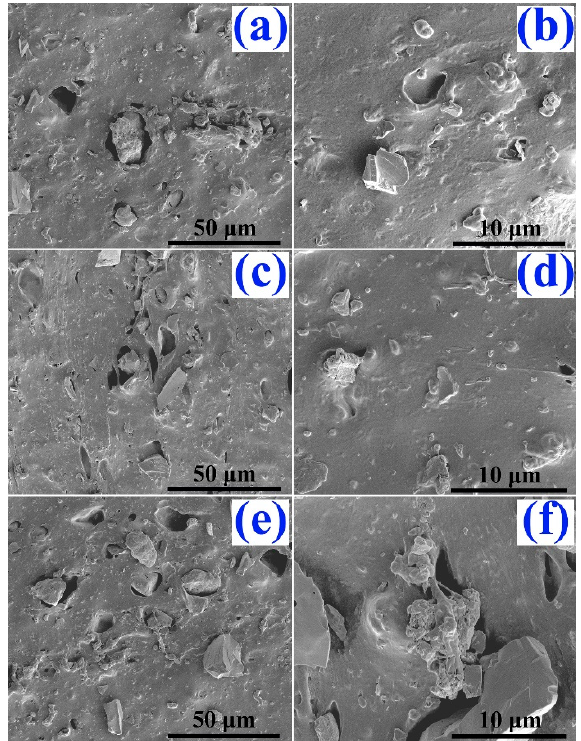
Figure 5. FE-SEM images of the fractured surface of the NR composites with different FD content (phr). ( a ) and ( b ) phr is 10; ( c) and ( d ) phr is 30; ( e ) and ( f ) phr is 50.